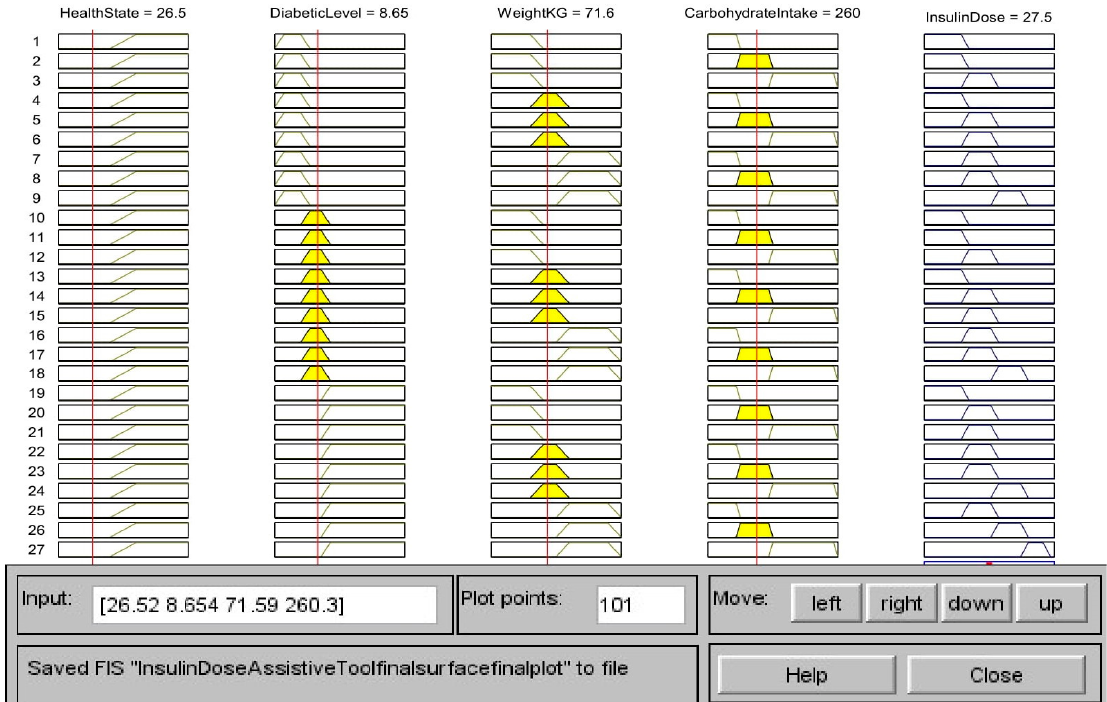
Figure 17. Output Insulin calculation based on the rules.